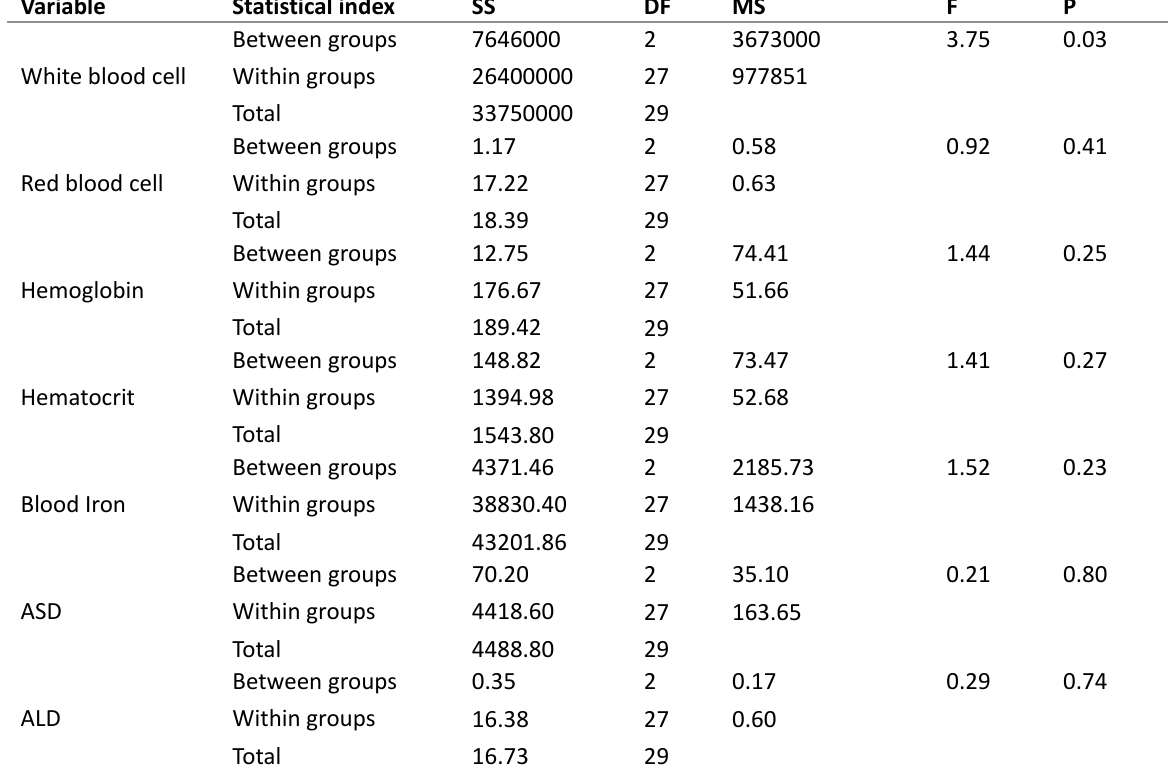
Table 2 . One-way analysis of variance test results for variables in post- test.